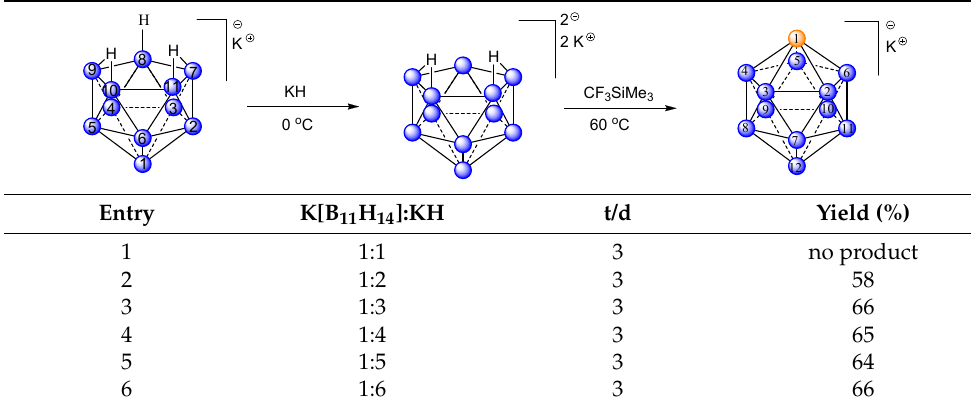
Table 1. Screening of the molar ratio of K[B 11 H 14 ] to KH a .